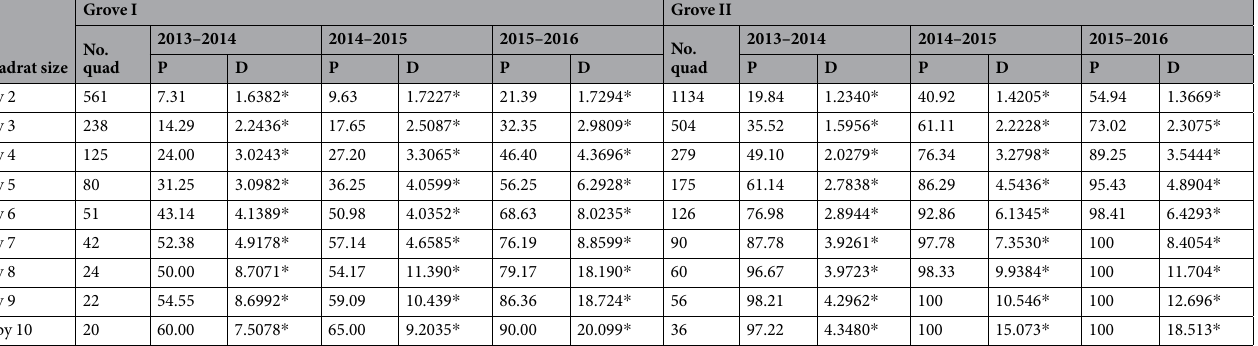
Table 3. Percentage of quadrats with at least one tree with citrus black spot ( P ), caused by Phyllosticta citricarpa , in groves I and II, and the respective binomial dispersion indexes 1 (D) for different combinations of quadrat sizes for three years studied. Pearson chi-square test for complete spatial randomness (CSR), values of p < 0.05 indicate a departure from CSR. Null hypothesis: There is no difference in the count of observed quadrats with at least one tree with fruit exhibiting CBS lesions when compared to the expected count of a homogeneous Poisson process. * p < 0.0001.